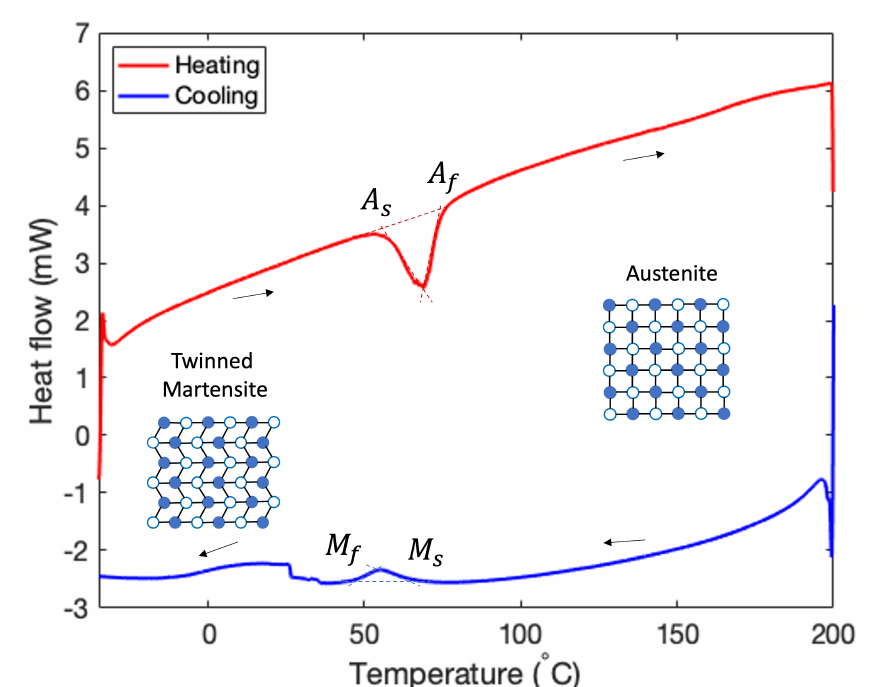
Figure 3. The DSC of the NiTi SMA wire depicts the transformation temperatures by intersecting tangents to the peak, A s at 56.99 ◦ C, A f at 74.48 ◦ C during the heating cycle (coloured blue), and M s at 66.42 ◦ C, M f at 45.67 ◦ C during the cooling cycle (coloured